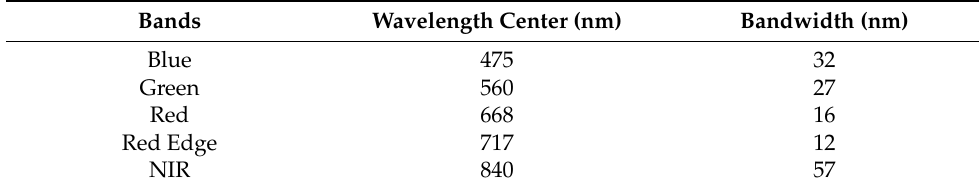
Table 1. Specifications of sentinel-2